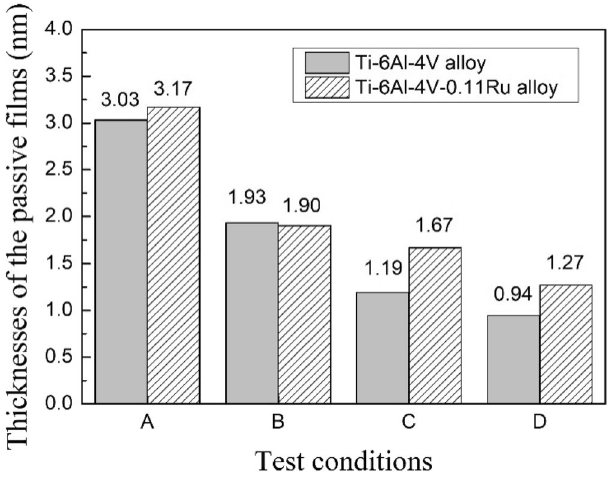
Figure 8. Thickness of the passive films for two alloys under different